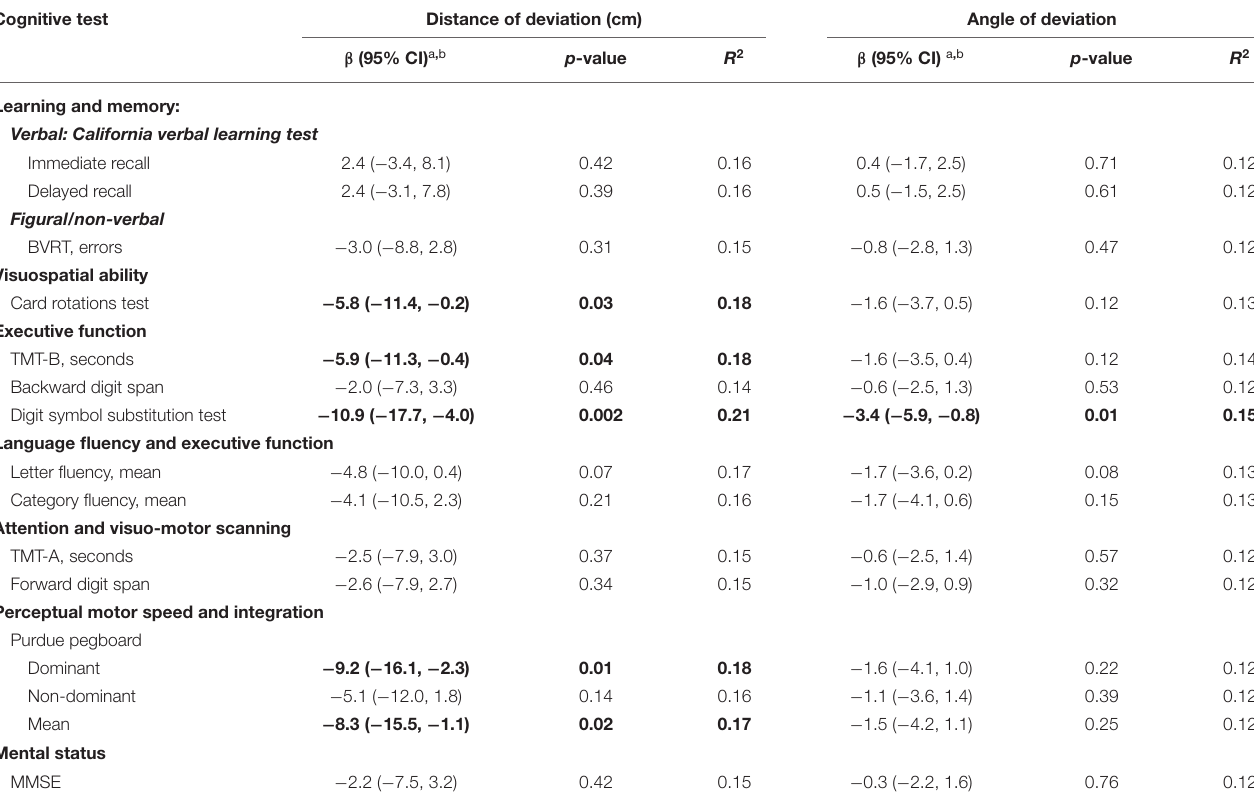
TABLE 3 | Multiple linear regression of deviation on the triangle completion task and cognitive function tests in the Baltimore Longitudinal Study on aging. Cognitive